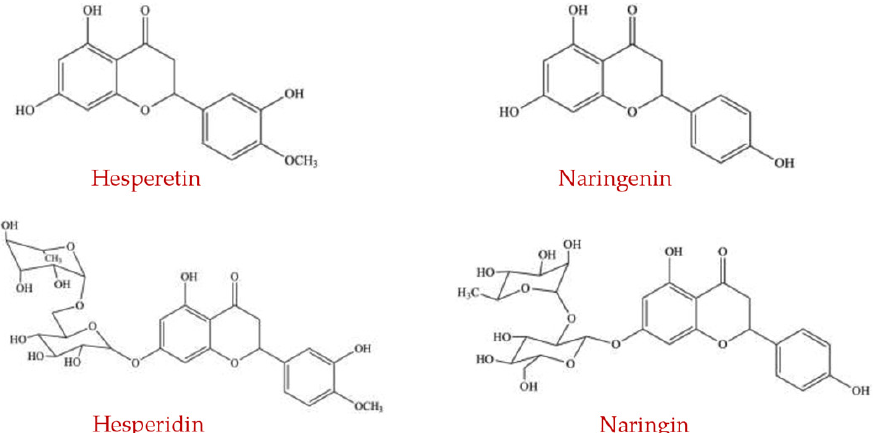
Figure 5. Chemical structures of flavanones (hesperetin, naringenin, hesperidin, and naringin)